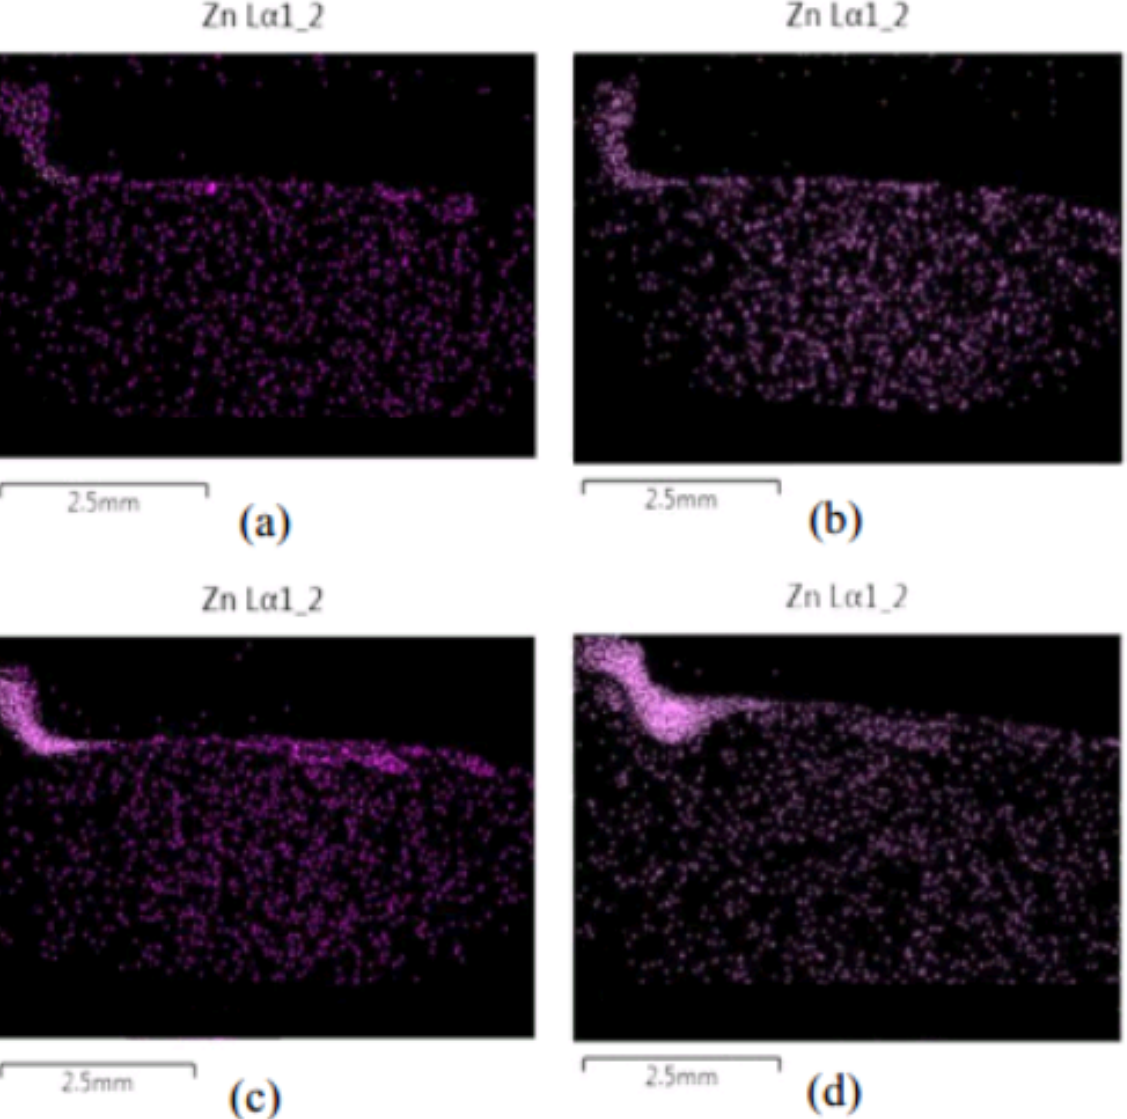
Figure 5: EDS mapping of friction stir-processed specimen under various Zn Particle volumes of (a) 22 mm 3 , (b) 45 mm 3 , (c) 67 mm 3 , and (d) 90 mm